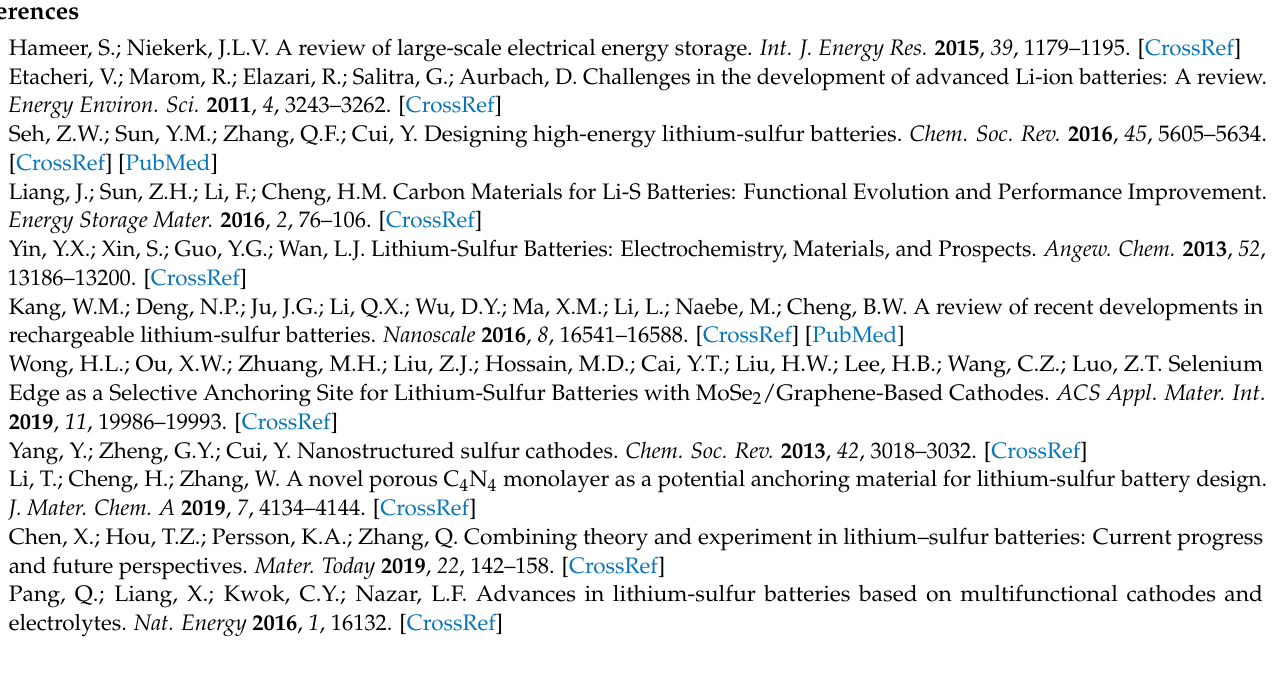
Blue balls represent N atoms. Figure S2: The possible orientation of Li2S with respect toTi 2 NS 2 . Figure S3: The optimized structures of DME and DOL absorbing (a) S 8 , (b) Li 2 S 8 , (c) Li 2 S 6 , (d) Li 2 S 4 , (e) Li 2 S 2 , and (f) Li 2 S. Figure S4: (a) Side and (b) top views of Ti 2 NS 2 . Red balls represent O atoms. Gray balls represent Ti atoms. Blue balls represent N atoms. Figure S5: The optimized structures of Ti 2 NO 2 absorbing (a) S 8 , (b) Li 2 S 8 , (c) Li 2 S 6 , (d) Li 2 S 4 , (e) Li 2 S 2 , and (f) Li 2 S. Purple balls represent Li atoms. Red balls represent O atoms. Gray balls represent Ti atoms. Blue balls represent N